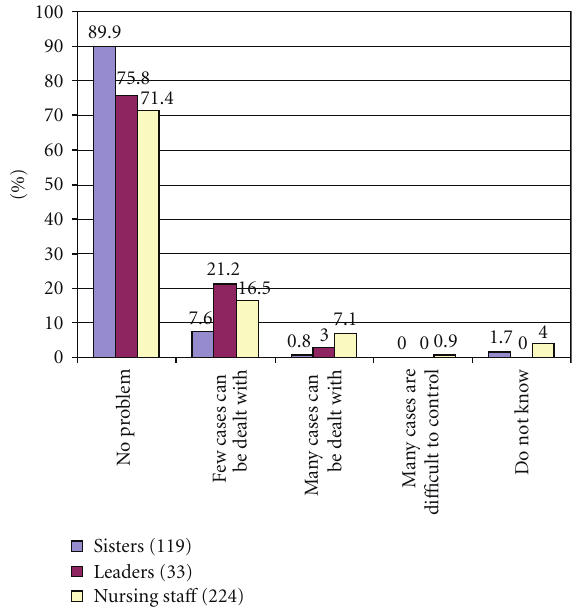
Figure 2: The size of the MRSA problem at your ward.